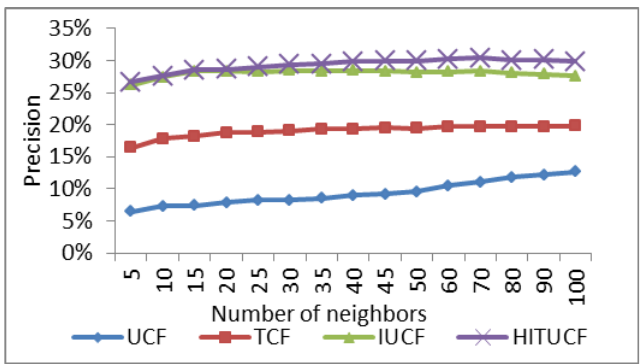
Figure 16. Relation between precision and number of neighbors on 100K Movielens dataset.